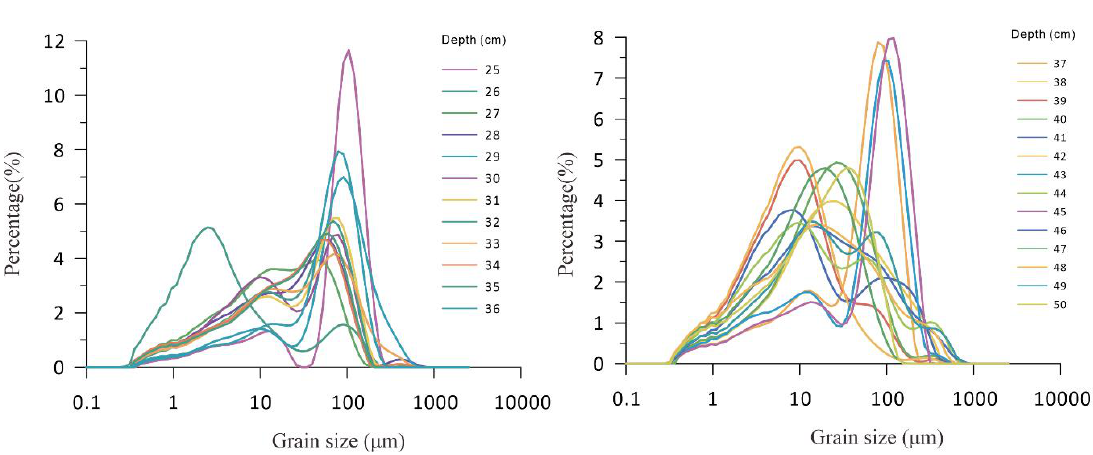
Figure 3. Distribution of grain-size frequencies in sediment core TLC01. Appl. Sci. 2020 , 10 , x FOR PEER REVIEW